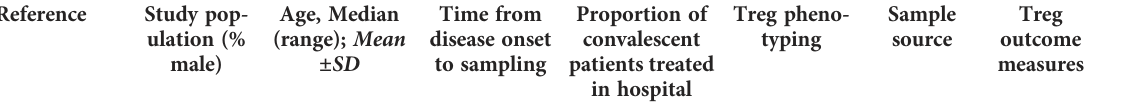
TABLE 1 Characteristics and main results of the included